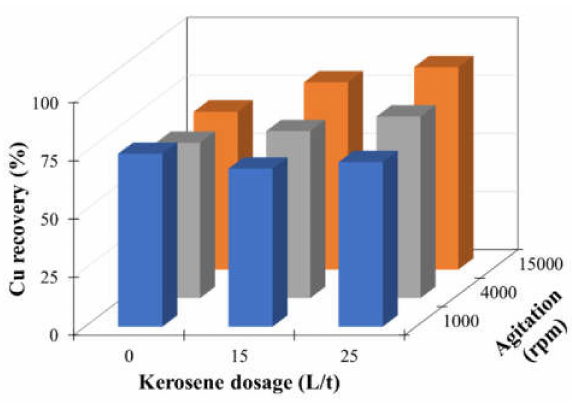
Figure 6. Effects of kerosene dosage and agitation speed on Cu recovery (KAX 200 g / t, flotation time 10